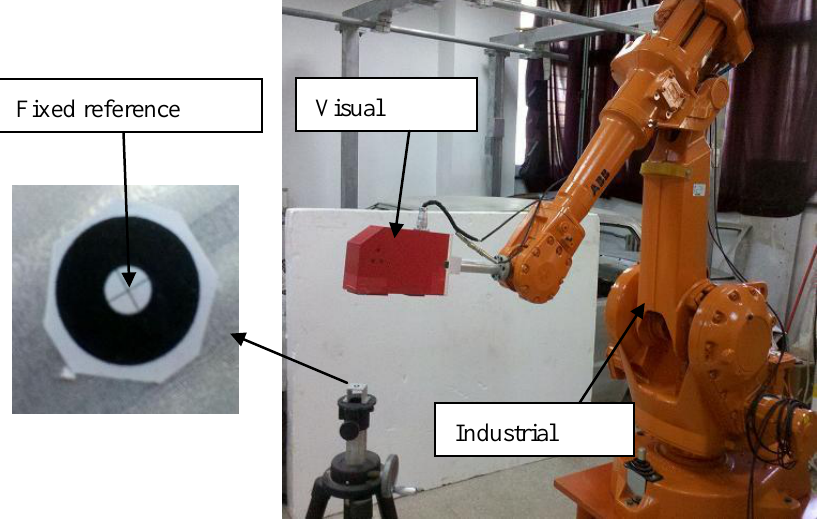
Figure 5. Experimental setup for robot